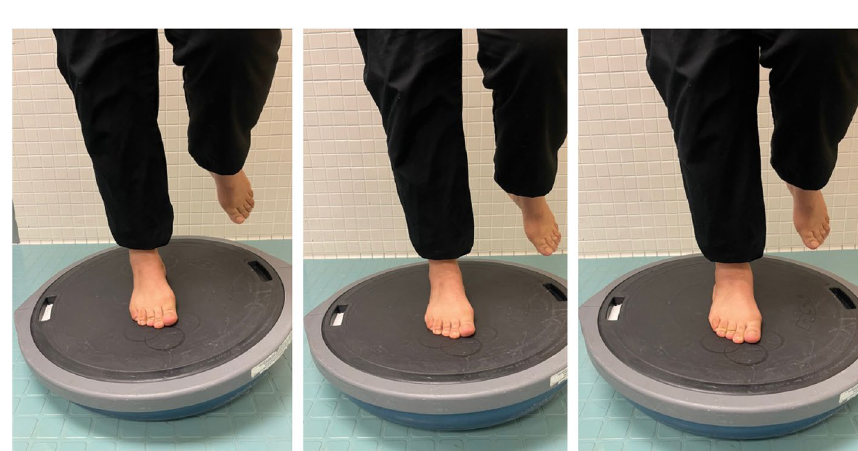
Fig. 5 Single leg ankle proprioceptive